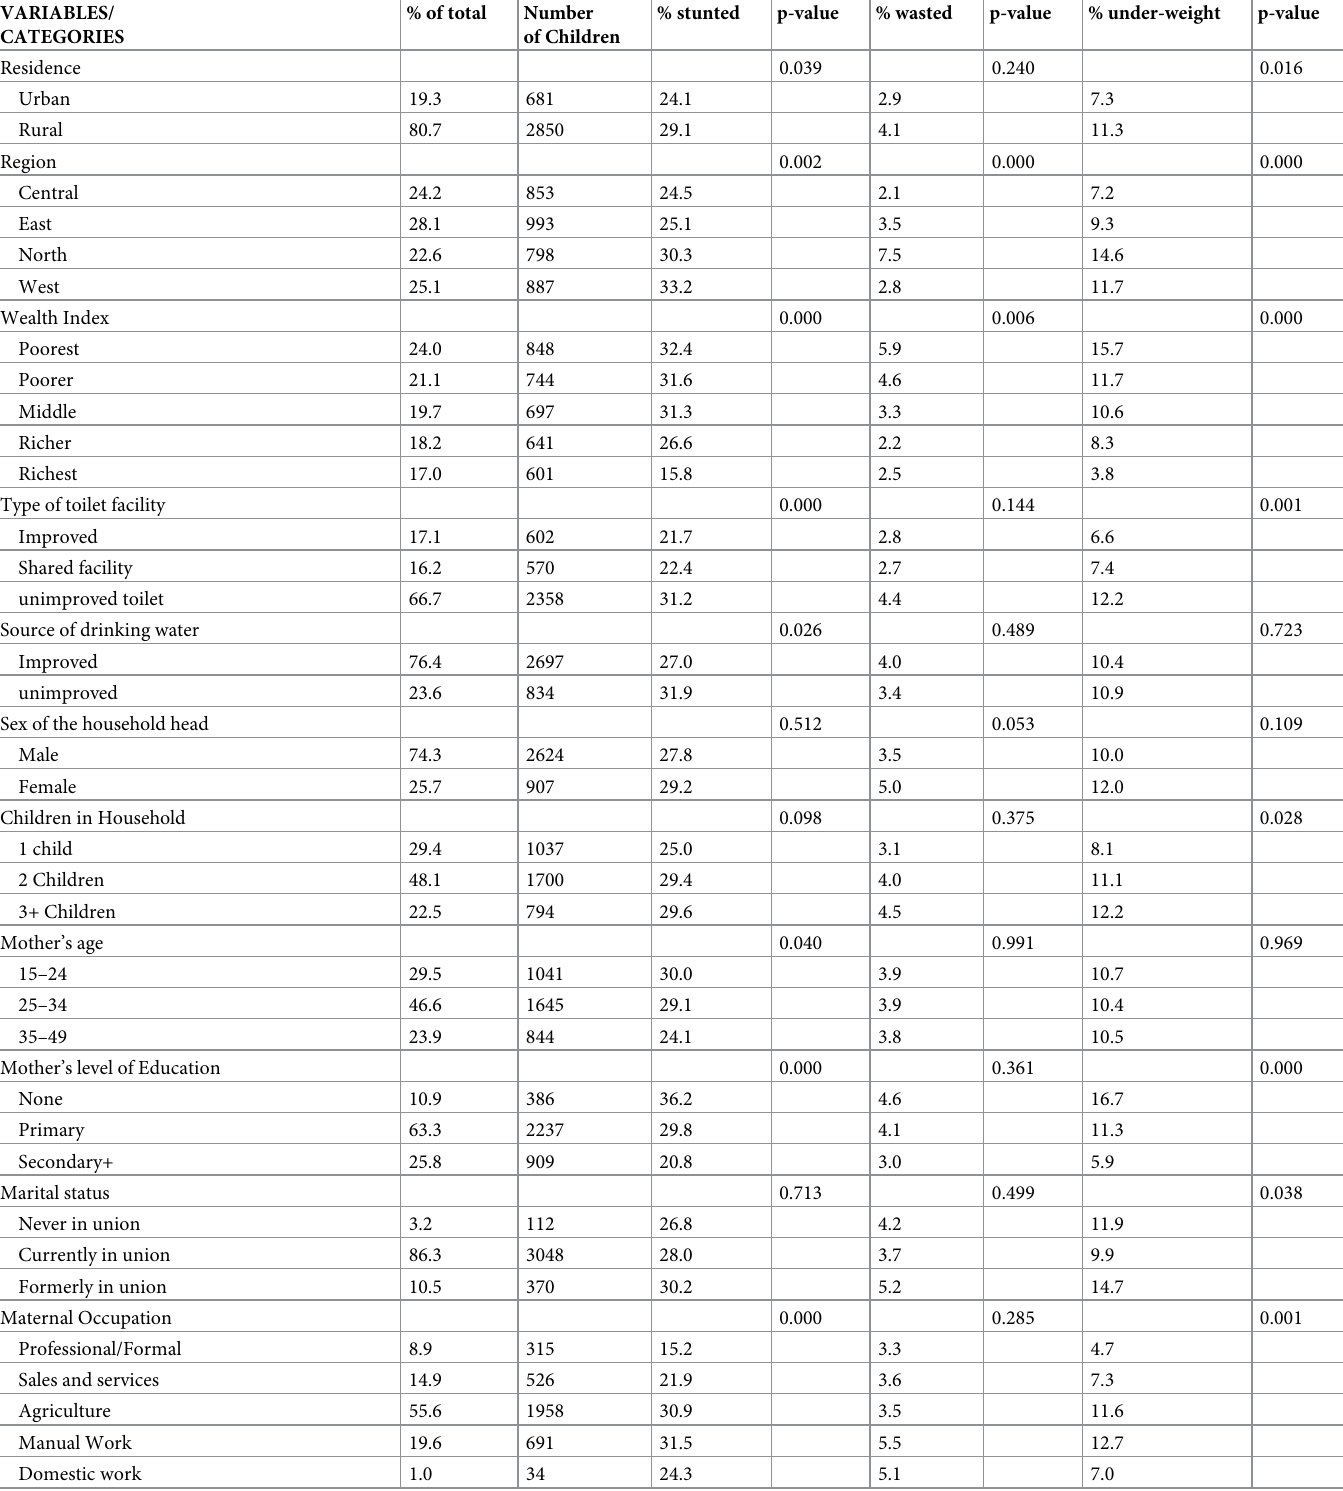
Table 1. Distribution of children by their household, mothers’ and demographic characteristics and their nutritional status. VARIABLES/